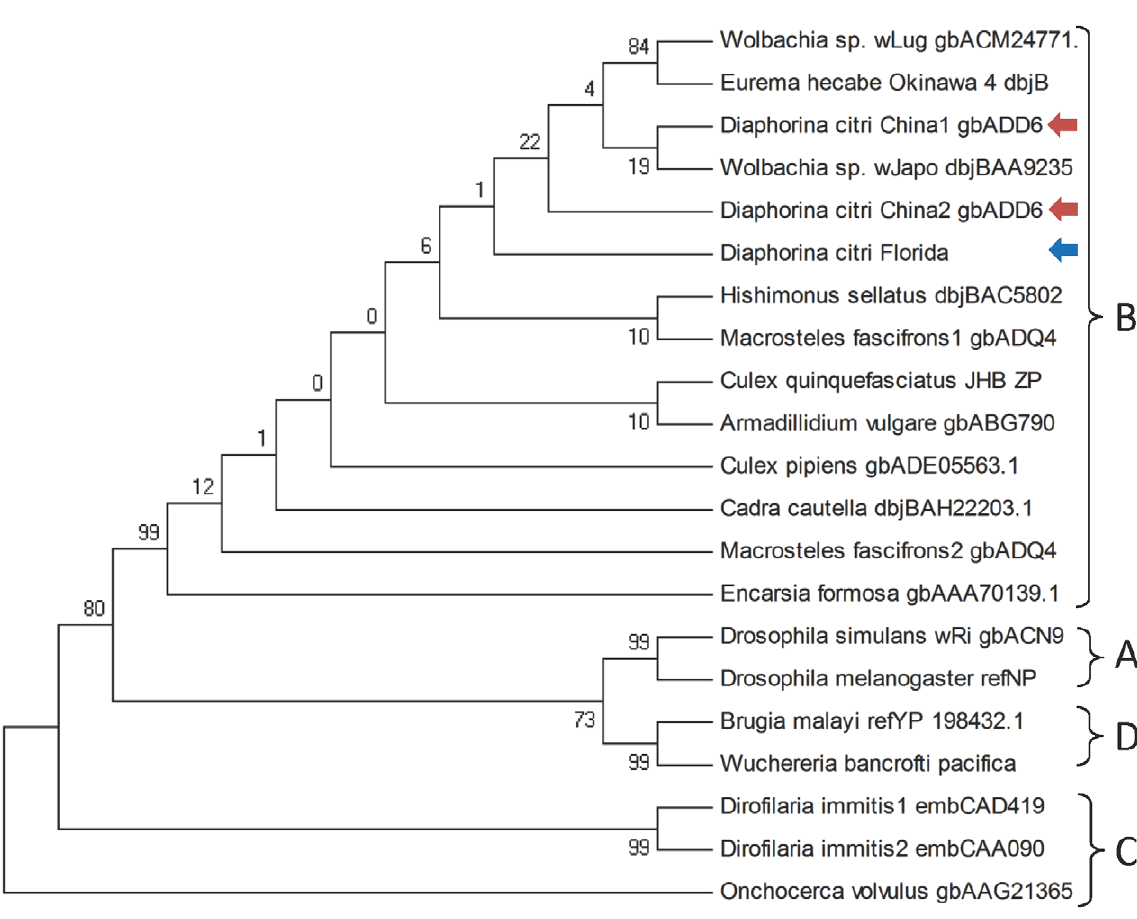
Figure 3. Maximum Parsimony tree for Wolbachia FtsZ sequences supporting placement of Wolbachia endosymbiont of Diaphorina citri (wDi) in supergroup B. Chinese strains are indicated with red arrows and the Florida strain with a blue arrow.